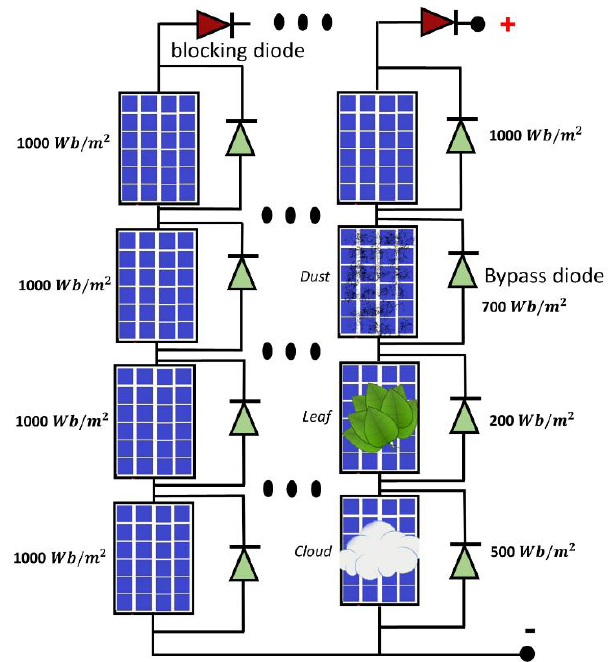
Figure 4. PV array in series-parallel combination with bypass and blocking diodes, under uniform and non-uniform irradiance.